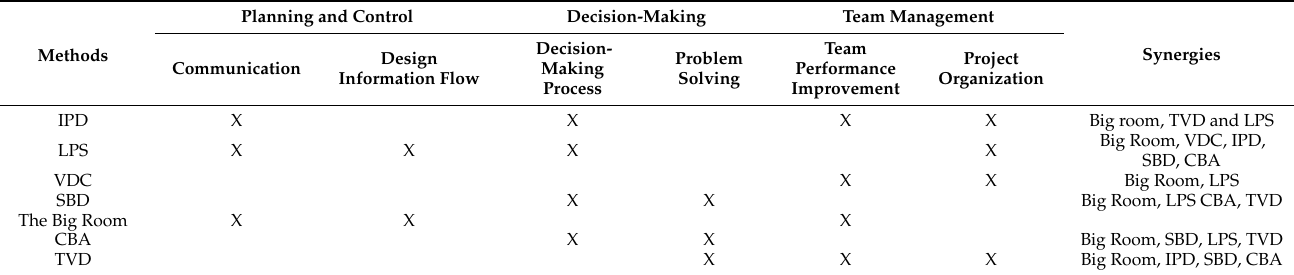
Table 3. Lean techniques applied in the design phase